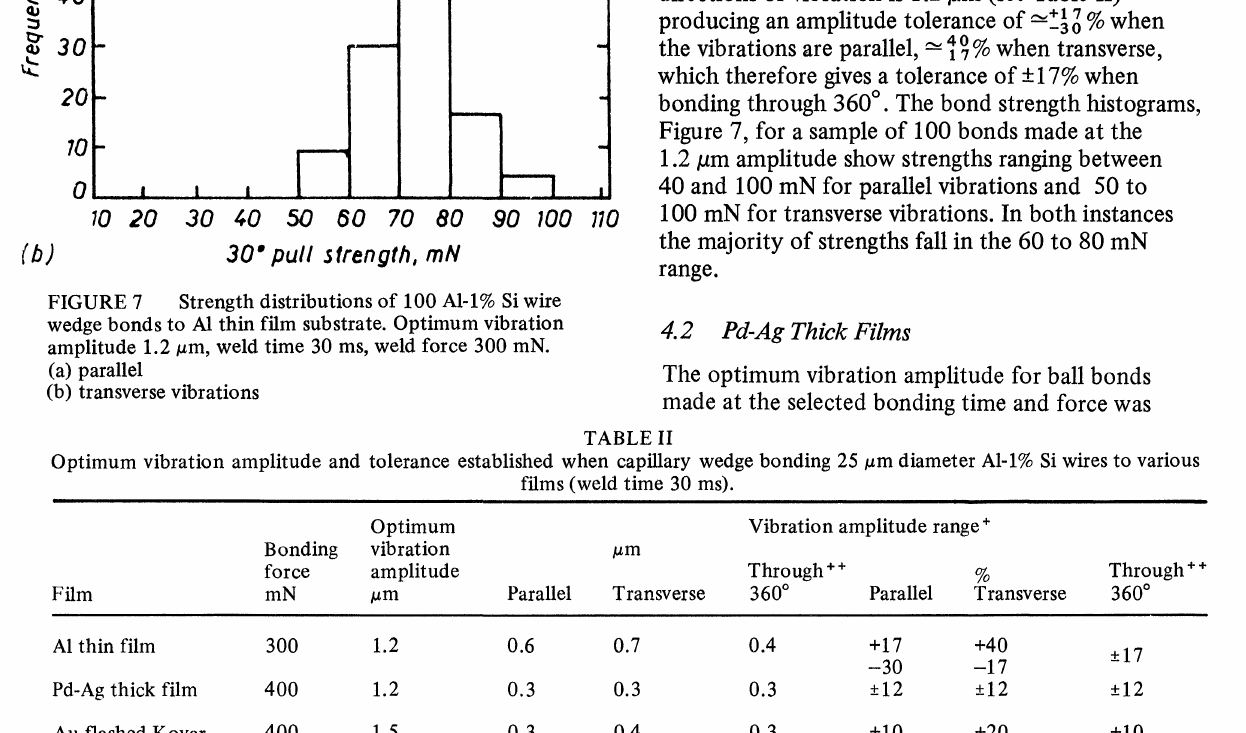
When making the capillary wedge bonds the vibration amplitude which was most suited to both directions of vibration is 1.2/am (see Table II)